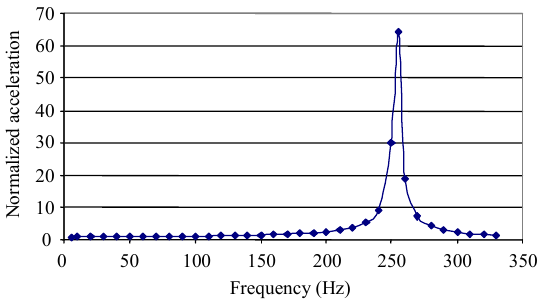
Fig. 4 Frequency response of the micro-seismic